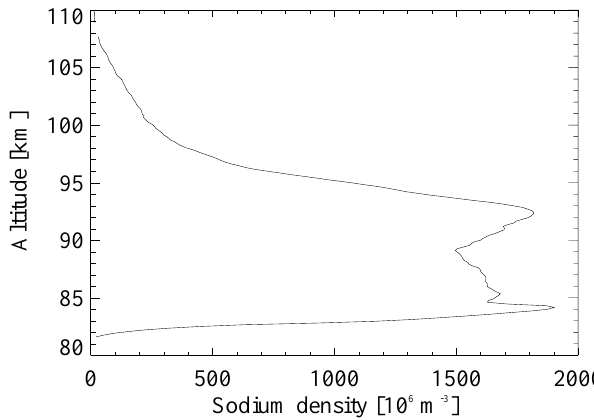
Fig. 2a. Sodium number density on 19 December 2010, 00:38:30UT. Average of 30s. Beam pointing: zenith. The sporadic meteor trail at 84km was observed for less than a minute.